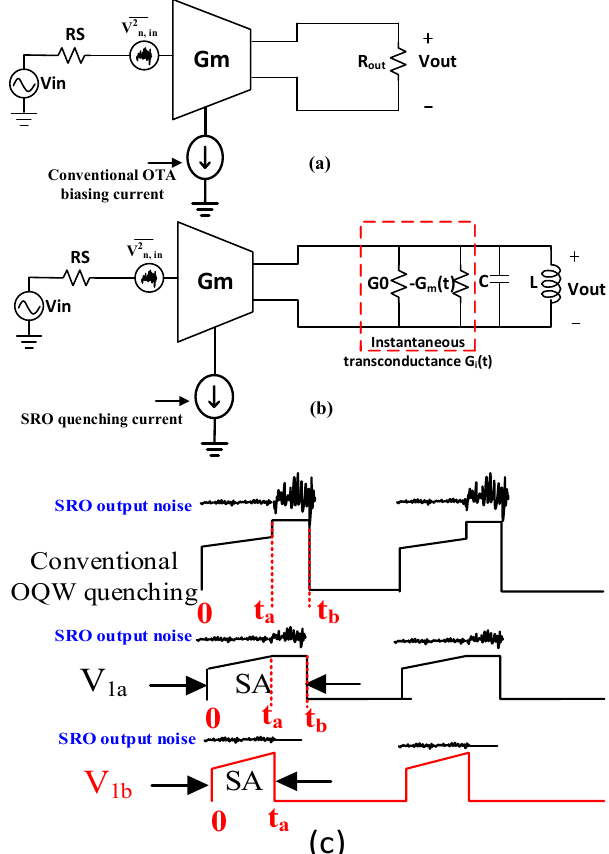
Figure 12. Noise analysis comparison between conventional OTA and SRO: ( a ) small signal model for OTA, and ( b ) SRO; ( c ) SRO quenching strategy and noise performance comparison.